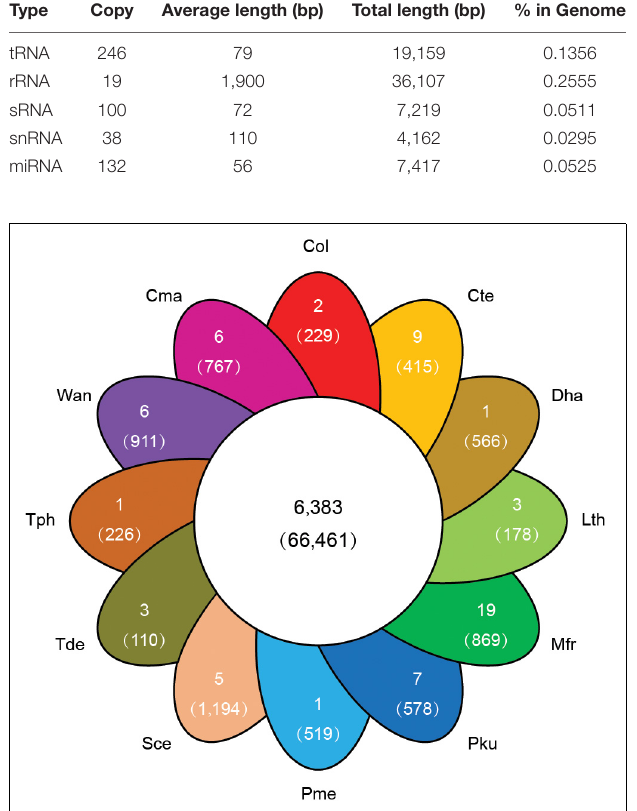
or have a specific phytochemical property within this species ( Figure 4 ). Functional enrichment analysis based on the GO annotation revealed that the specific proteins in C. oleophila tended to possess NADH dehydrogenase (ubiquinone) activity (GO:0008137) and glutathione peroxidase activity (GO:0004602) ( Supplementary Table S2